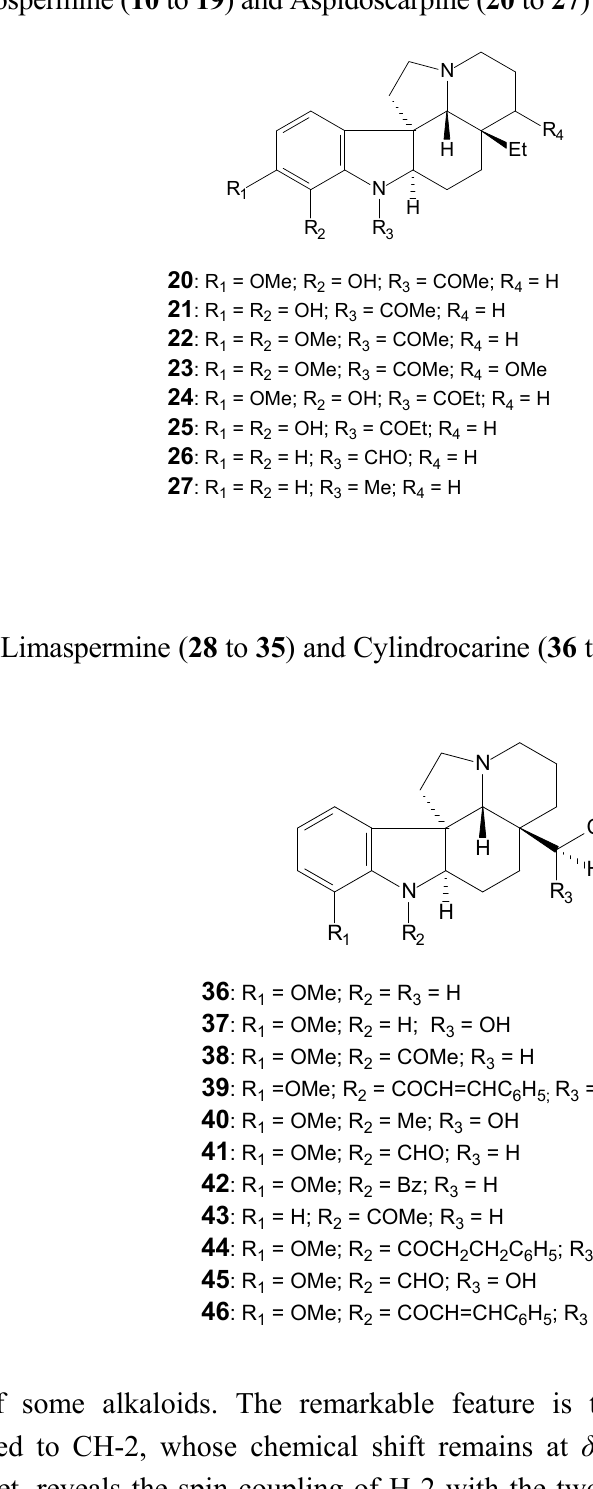
Figure 4. Plumeran indole alkaloids: Aspidospermine ( 10 to 19 ) and Aspidoscarpine ( 20 to 27 ) types [28].